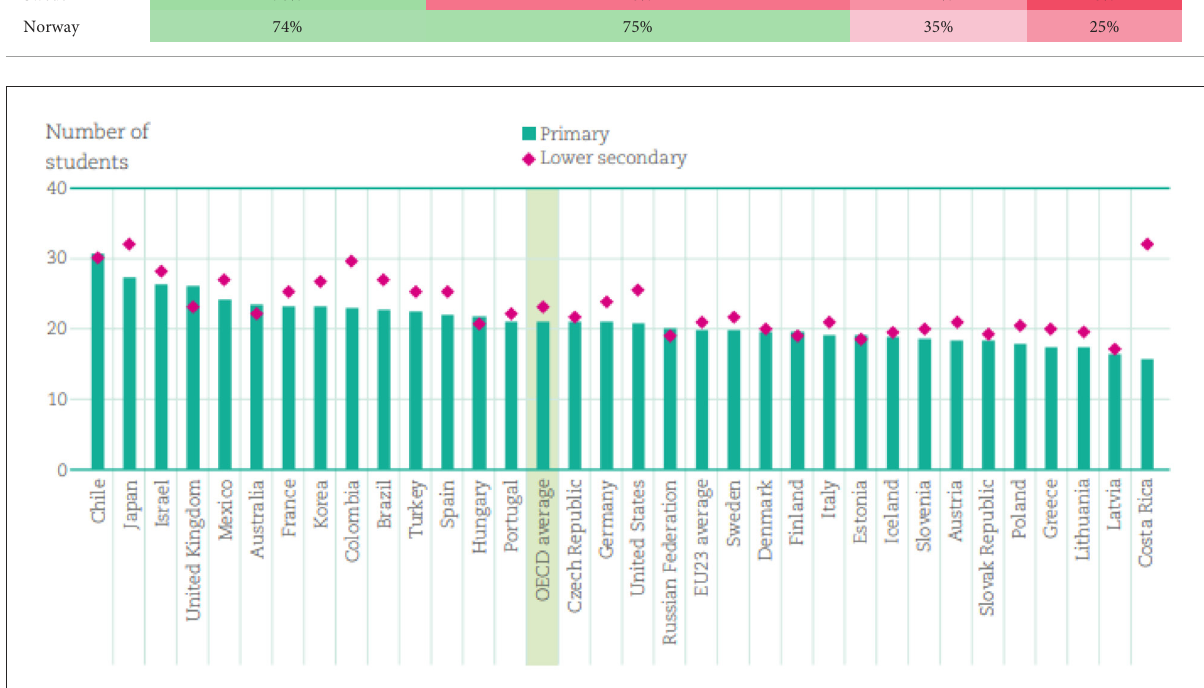
FIGURE6 Average class size, by the level of education